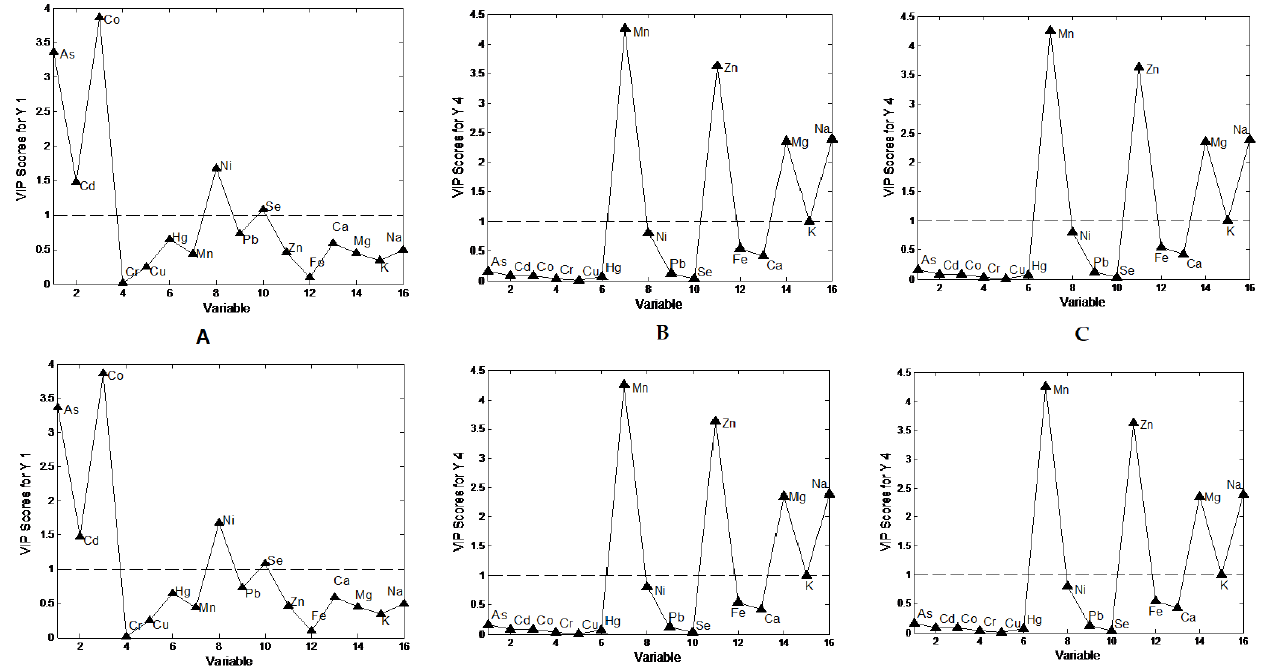
Figure 2. Partial least square-discriminant analysis performed on element analysis: plots of the variables versus VIP scores for: ( A ) V.philippinarum, ( B ) A.irradians, ( C ) M.yessoensis.